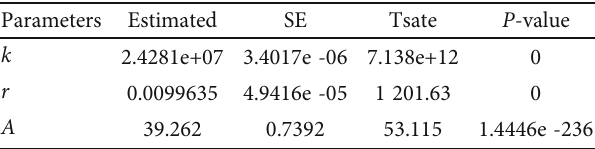
Table 3: Statistical analysis of the proposed system for